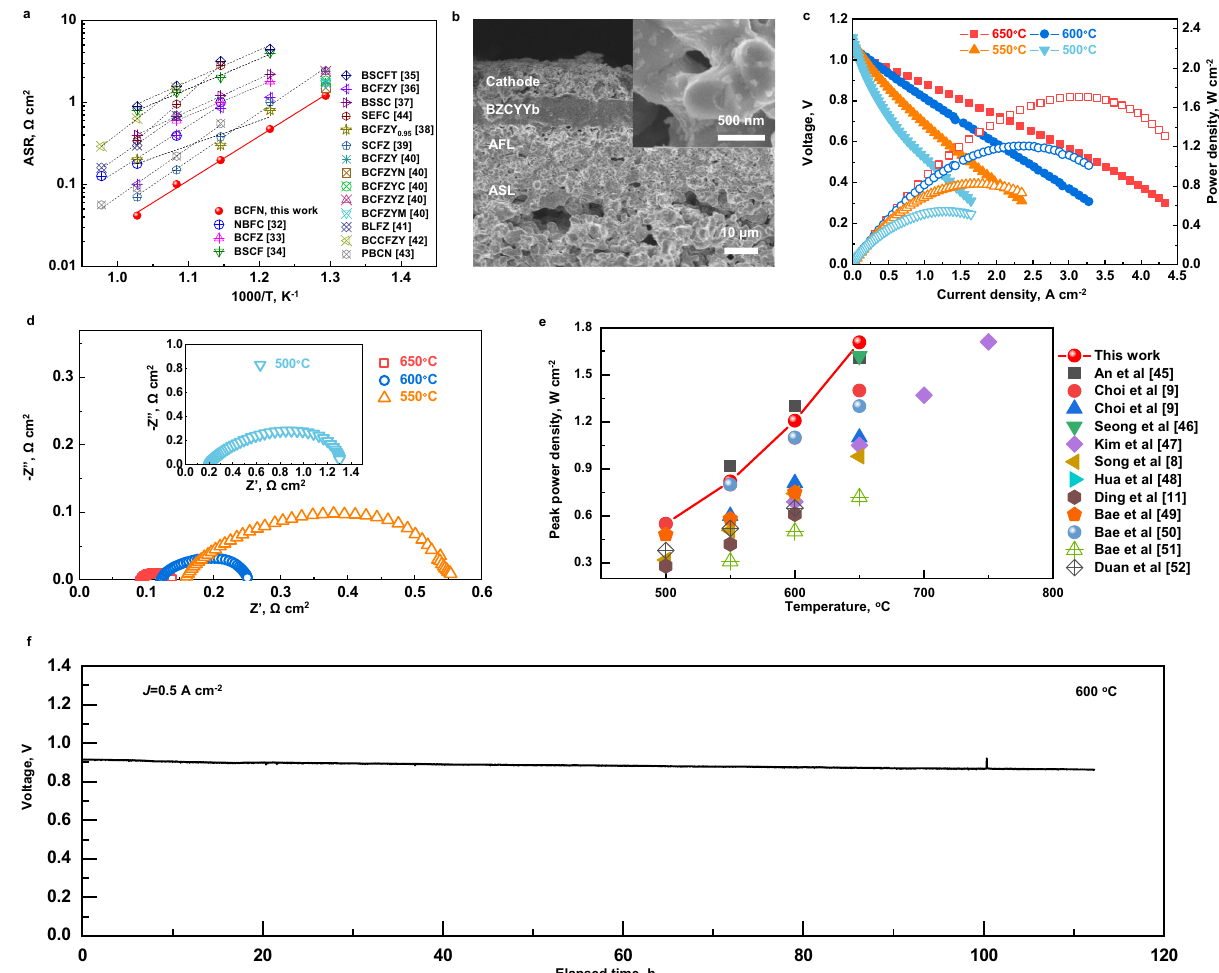
Fig. 3 Electrochemical performance of R-PCECs with a BCFN air electrode in the FC mode. a Temperature dependence of the polarization resistance ( R p ) of a symmetrical cell with BCFN and other high-performance electrodes 32 – 44 , as shown in Supplementary Table 1; b A cross-section image of a Ni-BZCYYb fuel electrode supported single cell. Inset is the detailed SEM image of cathode; c Typical I-V-P curves of the single-cell measured at 650, 600, 550, and 500 °C, respectively; d Typical EIS curves of the single cell under OCVs using H 2 (3% H 2 O) as the fuel and ambient air as the oxidant, measured at 650, 600, 550, and 500 °C, respectively; e The comparison of the peak power densities of PCFCs with different cathode materials 8,9,45 – 53 , and BCFN (this work), tested from 800 to 500 °C; and f A short-term stability test of the single cell at a constant current density of 0.5 A cm − 2 and 600